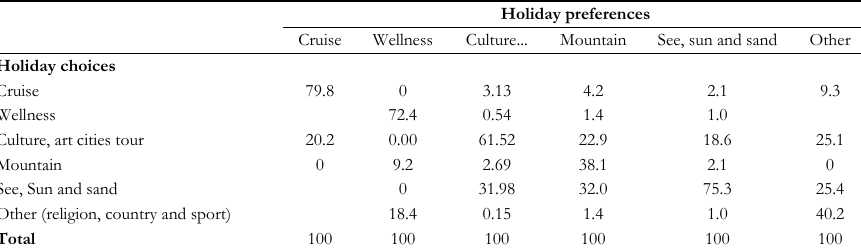
Effective choice destinations distribution for each preference class Holiday